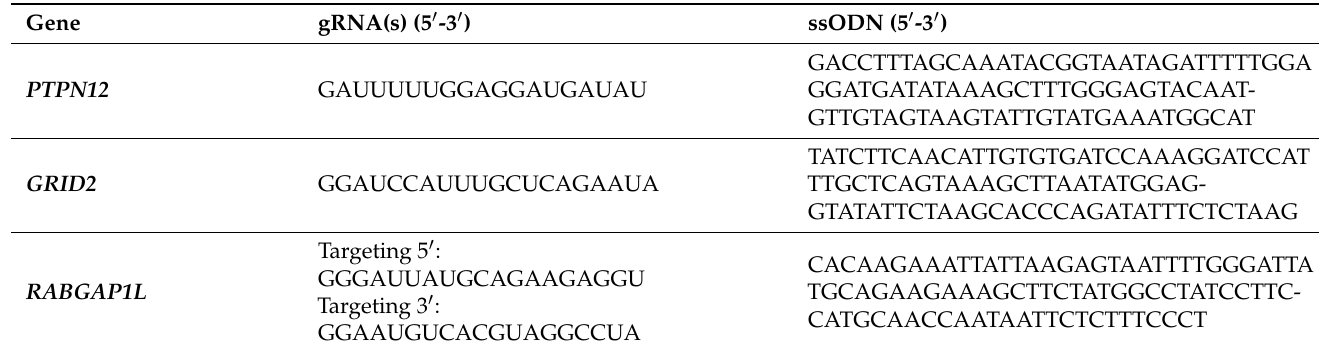
Table 1. Guide RNAs and single-stranded oligo donors used in gene-editing.